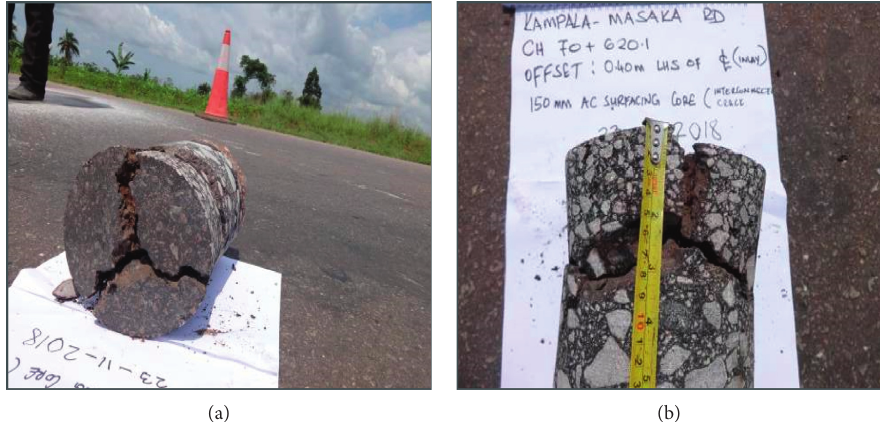
Figure 3: Interconnected cracks confined to the upper portion of the surfacing.